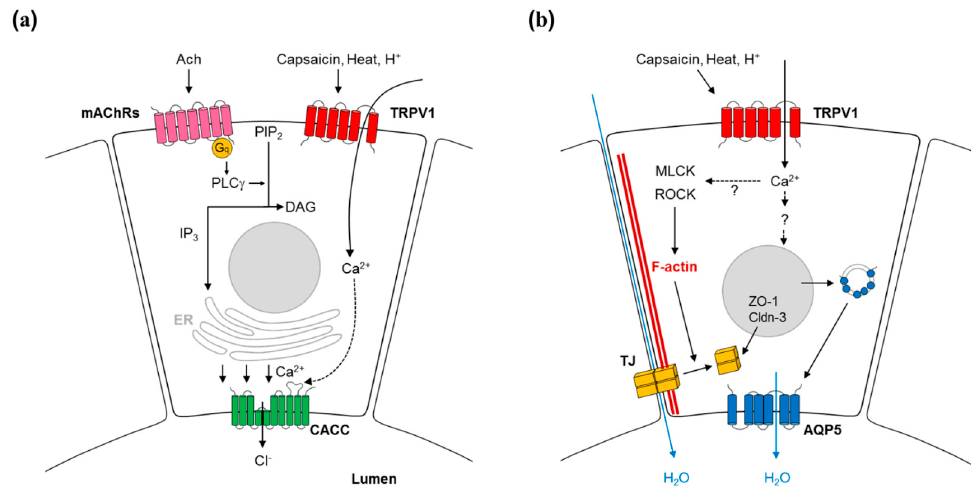
Figure 1. Capsaicin mediates saliva secretion via transient receptor potential vanilloid subtype 1 (TRPV1). ( a ) Calcium-activated chloride channel (CACC)-induced saliva secretion. Activation of